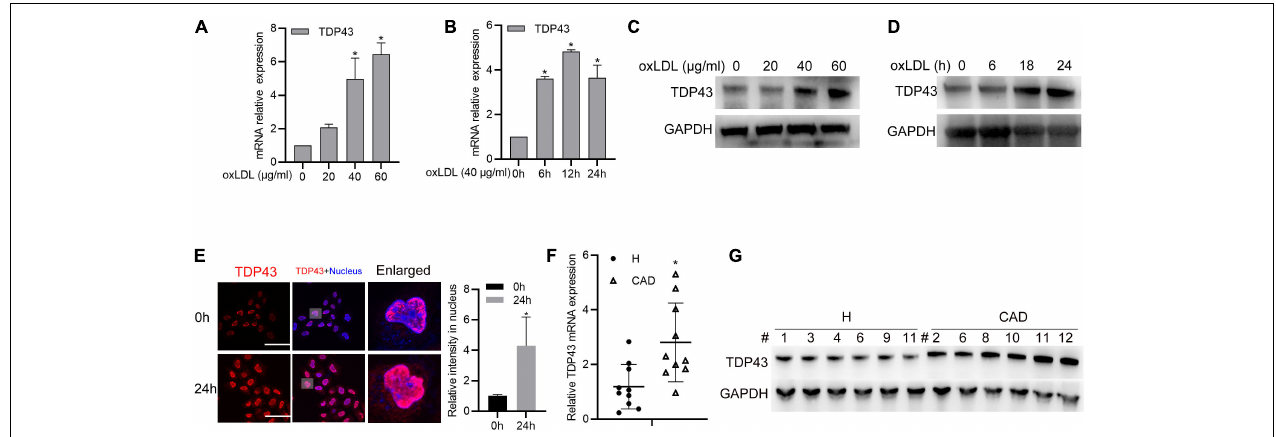
FIGURE 1 | Transactive response DNA-binding protein ∼ 43 kDa (TDP43) expression is upregulated in oxLDL-treated macrophages and peripheral blood mononuclear cells from patients with CAD. (A) qPCR detection of TDP43 mRNA in macrophages treated with the indicated concentrations of oxLDL for 24 h. Data are represented as means ± SD ( n = 3; * P < 0.05 vs. 0 µ g/ml oxLDL stimulated group). (B) qPCR detection of TDP43 mRNA in macrophages treated with 40 µ g/mL oxLDL for the indicated time points. Data are represented as means ± SD ( n = 3; * P < 0.05 vs. 40 µ g/ml oxLDL stimulated for 0 h group). (C) Western blot analysis of TDP43 expression in macrophages treated with the indicated concentrations of oxLDL for 24 h. GAPDH was used as a loading control. (D) Western blot analysis of TDP43 expression in macrophages treated with 40 µ g/mL oxLDL for the indicated time points. (E) Immunofluorescence analysis of TDP43 cellular distribution in macrophages treated with or without 40 µ g/mL oxLDL for 24 h. Data are represented as means ± SD ( n = 50; * P < 0.05 vs. 40 µ g/ml oxLDL stimulated for 0 h group). Scale bar = 100 µ m. (F) qPCR detection of TDP43 mRNA in PBMCs isolated from health volunteers (H) or patients with (CAD) Data are represented as means ± SD ( n = 10; *represents P < 0.05 vs. H group) (G) Western blot analysis of TDP43 expression in PBMCs isolated from health volunteers or patients with CAD. GAPDH was used as a loading